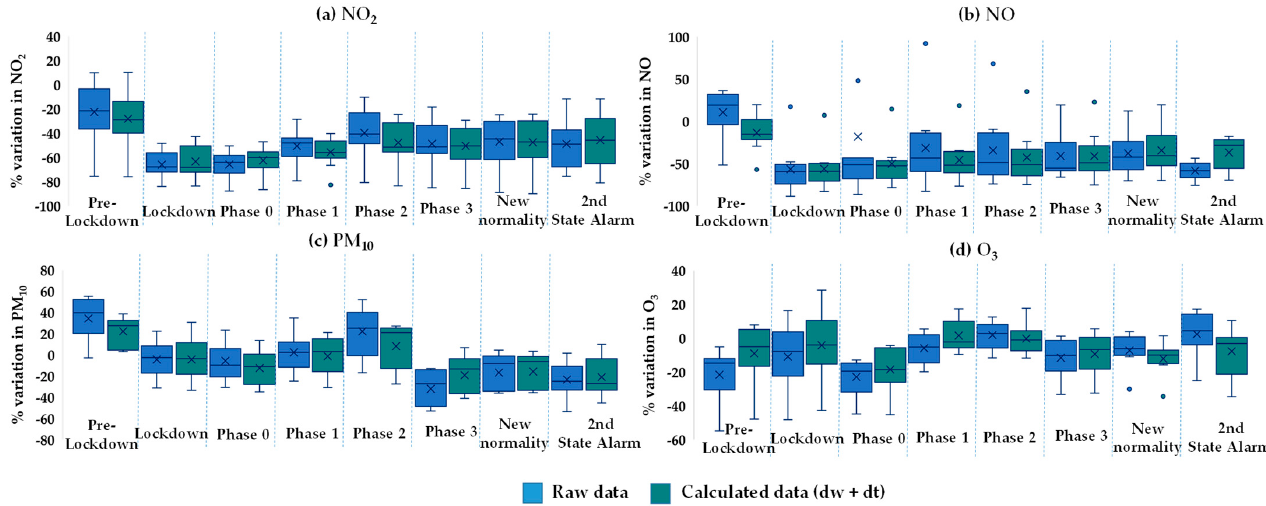
Figure 7. Box plots of variations (%) in pollutant concentrations ( a ) NO 2 , ( b ) NO, ( c ) PM 10 , ( d ) O 3 , at all studied sites from raw data (blue) and calculated data (green) after using the “deweather” package, comparing 2020 levels with the mean of the previous seven years (2013–2019) in each period. Note that arithmetic mean values are marked with a cross and whiskers represent the minimum and maximum non-outlier values.